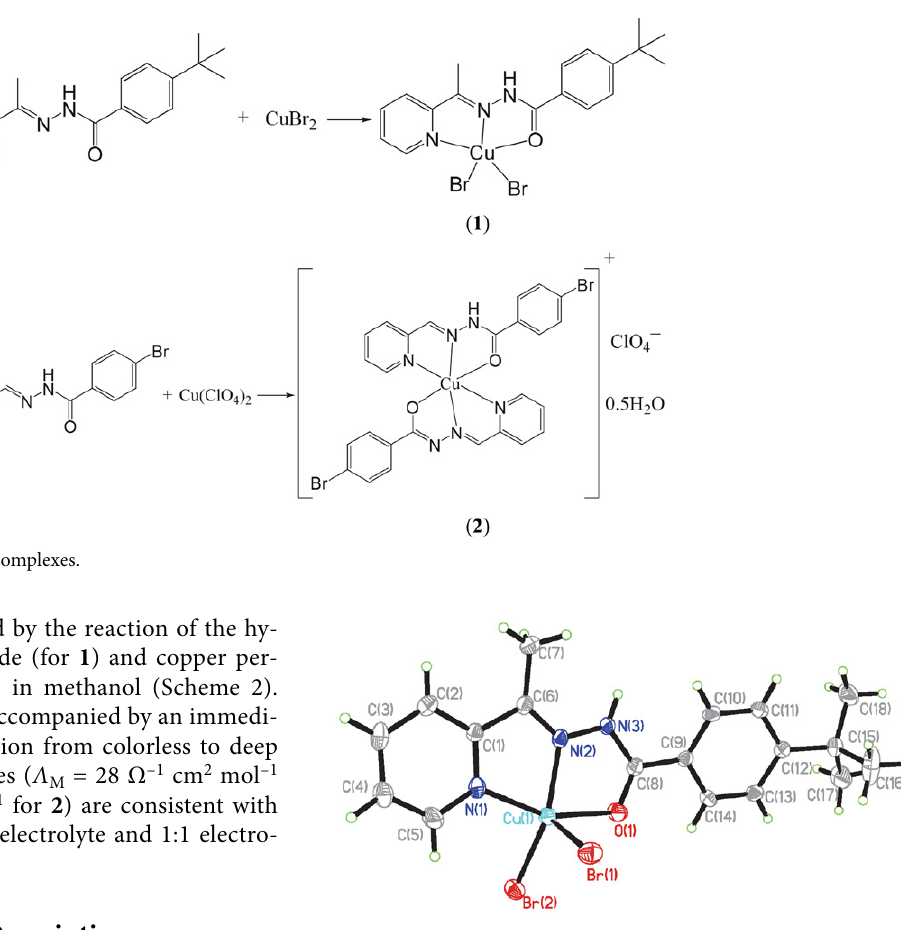
Fig. 1. ORTEP diagram of complex 1 with 30% thermal ellipsoid.